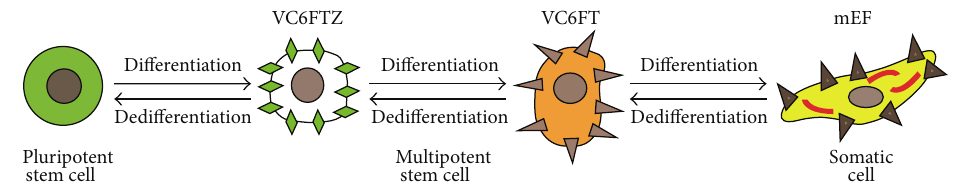
Figure 2: Small molecules based iPSC generation. Small molecules can substitute for all TFs through epigenetic modifications and signaling pathway regulations. Hou et al. reported that CiPSC generation from mEF was carried out in 3 steps of 16–20 days in VC6TF treatment and then 12–20 days in VC6TFZ and followed by 2i compounds regulations for 1 week. The somatic cell, mouse embryonic fibroblast (mEF) cell, undergoes dedifferentiation and gains multipotent stem cell characteristics under the treatments of VC6TF and VC6TFZ steps and finally obtains the full pluripotency in the medium containing 2i compounds (Chir99021 and